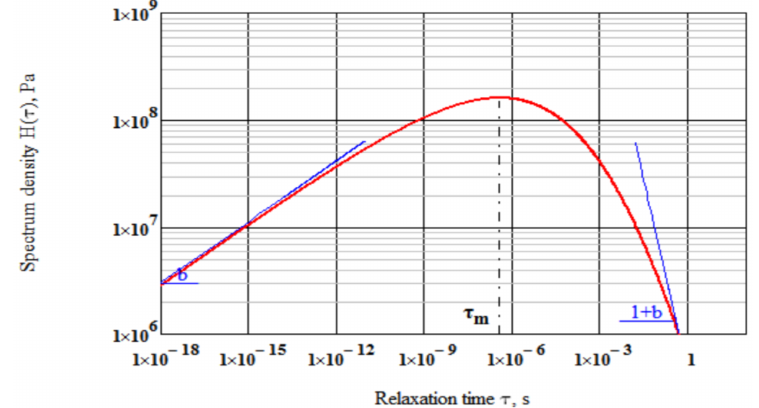
Figure 3. Spectrum and geometrical meaning of parameter b